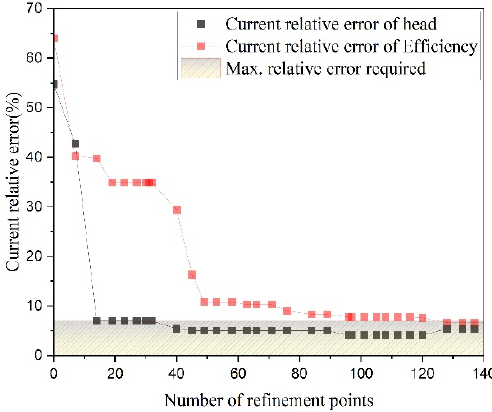
Figure 7. Convergence curves for the Sparse Grid approximation model.